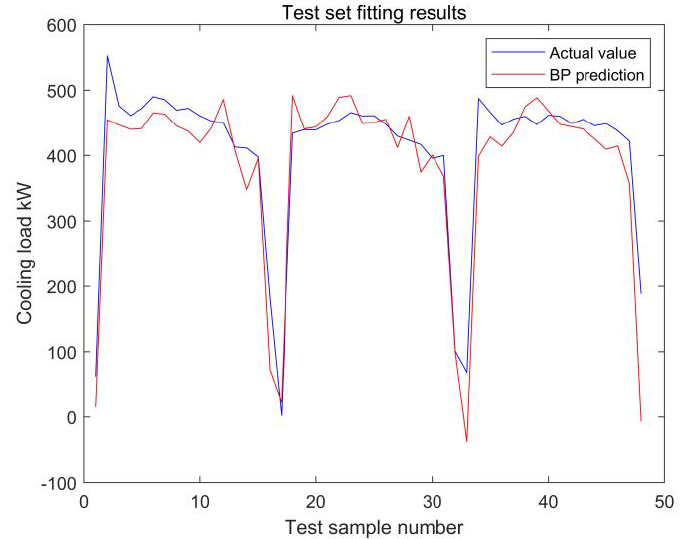
Figure 21. Fitting effect of the test set.